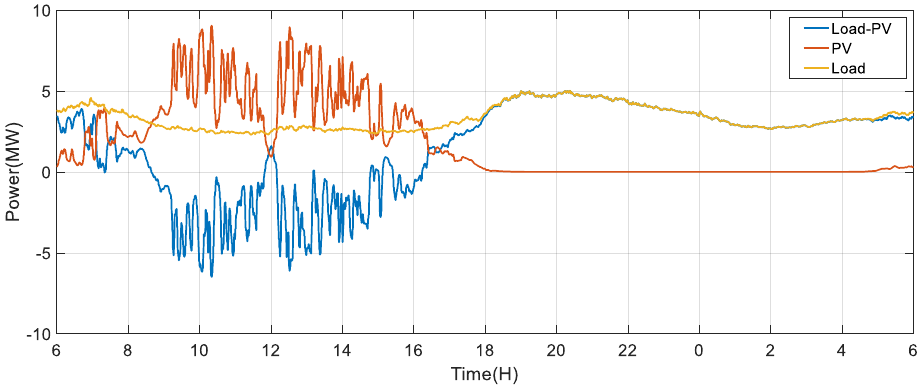
Figure 8 . State of charge (SOC) curve of a BESS. Figure 8. State of charge (SOC) curve of a BESS.